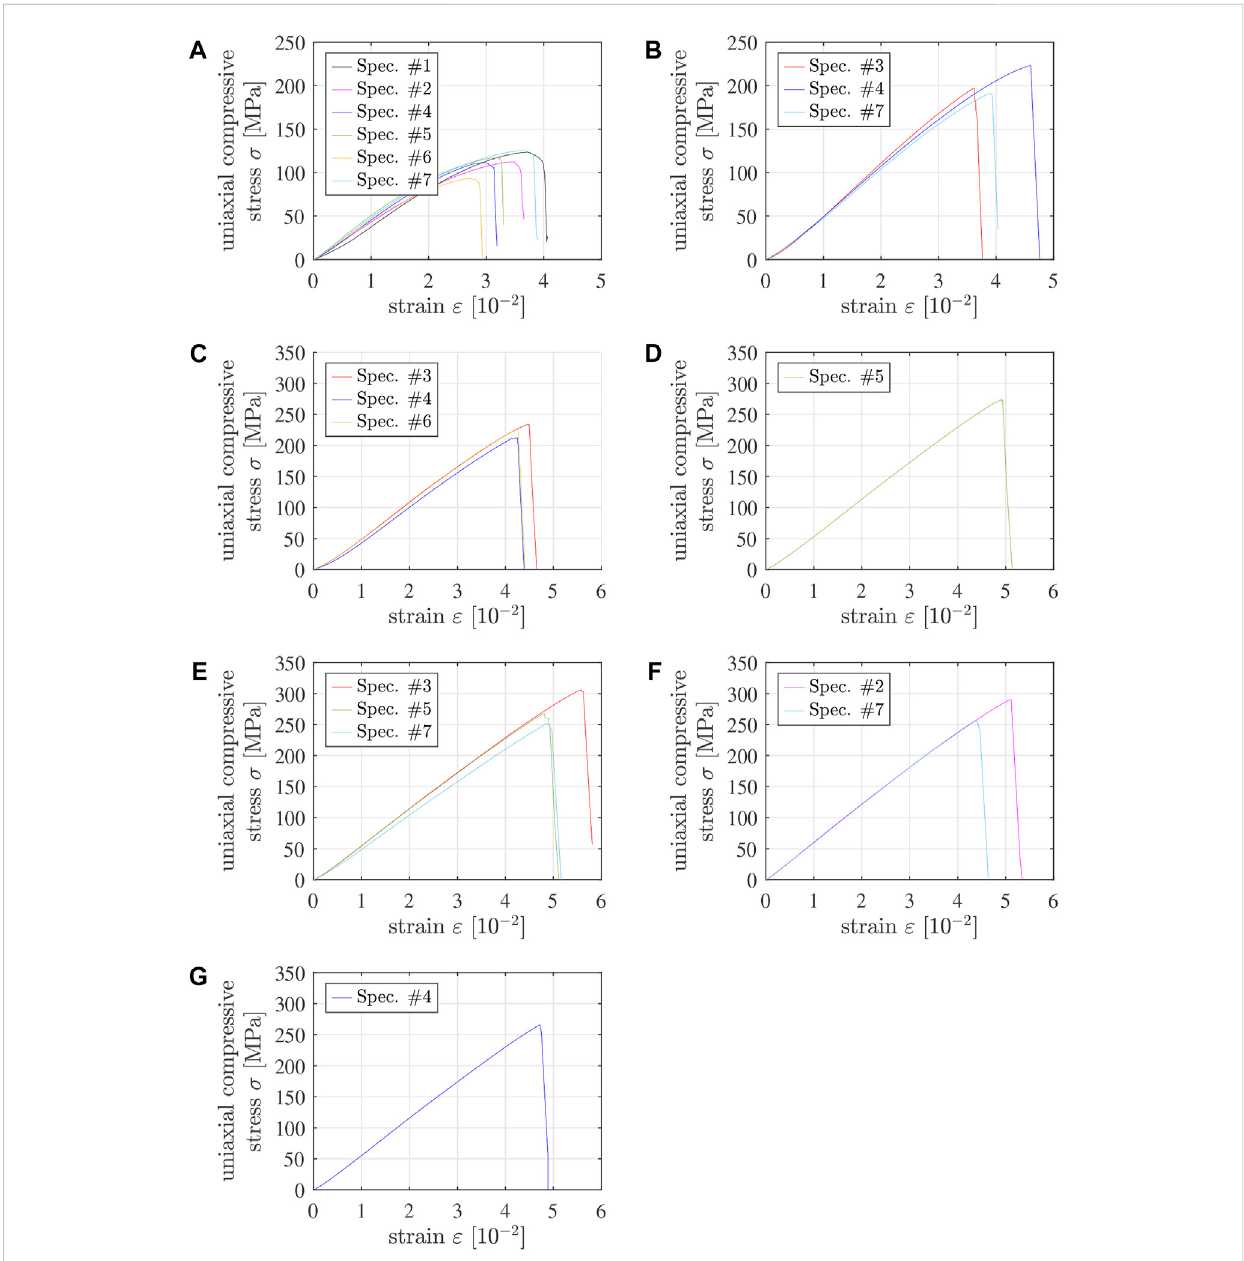
FIGURE 5 Stress-strain diagrams from destructive compression experiments of 4/6 specimens tested (A) 1.5 h, (B) 7.5 h, (C) 25.5 h, (D) 7 days, (E) 14 days, (F) 21 days,and (G) 28 daysafterproduction;thesolidgraphsrefertospecimens#1throughout#7,withthefollowingcolorcode:#1-black,#2-pink,#3- red, #4 - dark blue, #5 - green, #6 - yellow, #7 - light blue, see also Table 5 and Supplementary Table S2. Note that “ strain ” refers to the sum of the absolute values of the compressive axial strain undergone by the specimen and the tensile axial strain undergone by the testing